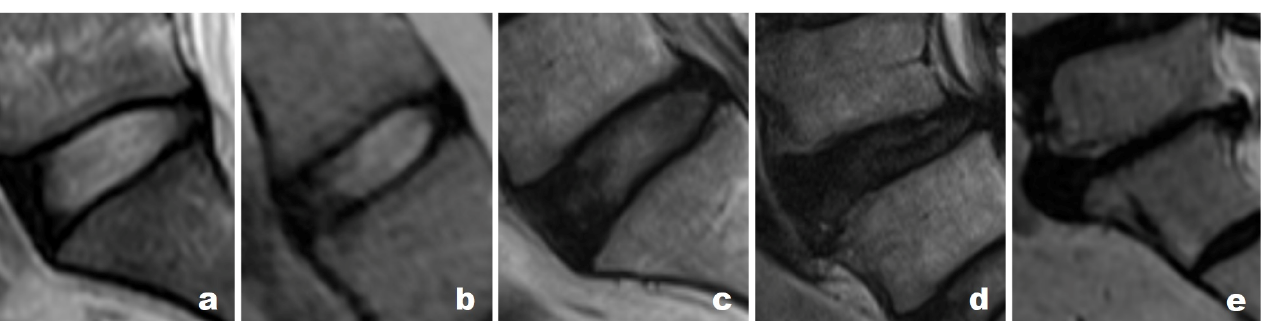
Figure 2. Pfirrmann grading of intervertebral disc degeneration. ( a ) Grade I: Homogenous and bright white disc with clear distinction between the nucleus and annulus, with signal intensity being hyperintense/isointense to cerebrospinal fluid and maintaining normal height. ( b ) Grade II: Inhomogeneous disc with or without horizontal bands and a clear distinction between nucleus and annulus, with signal intensity being hyperintense/isointense to cerebrospinal fluid and maintaining normal height. ( c ) Grade III: Inhomogeneous gray disc with unclear distinction between nucleus and annulus with signal intensity being intermediate and having normal to slightly decreased height. ( d ) Grade IV: Inhomogeneous gray to black disc with loss of distinction between nucleus and annulus, and with signal intensity being intermediate to hypointense and having normal to moderately decreased height. ( e ) Grade V: Inhomogeneous black disc with loss of distinction between nucleus and annulus with signal intensity being hypointense and appearing collapsed.